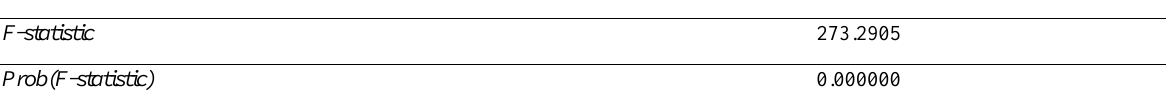
Table 6: F Test Result